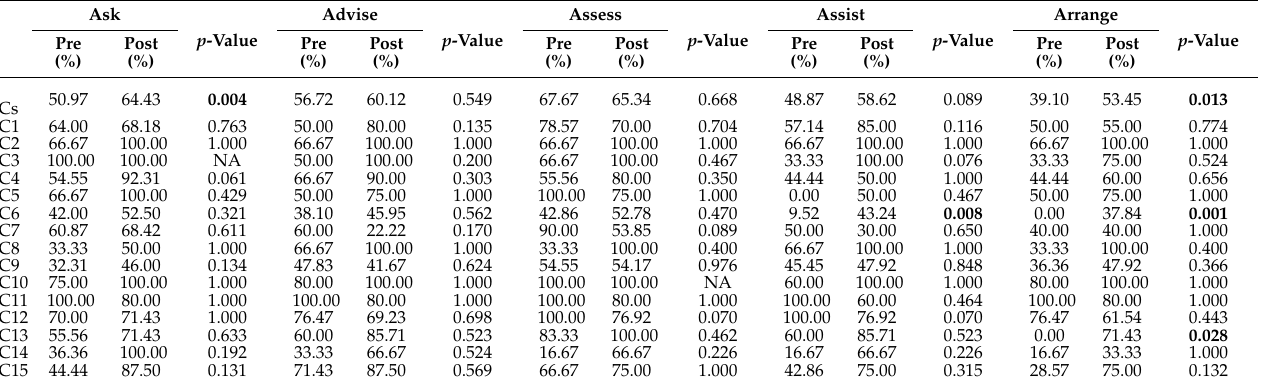
Table 1. Providers’ Delivery of the 5A’s for Non-cigarette Tobacco Use From Before to After a Comprehensive Tobacco-Free Workplace Program Implementation Within Each of the 15 Participating Substance Use Treatment Centers.